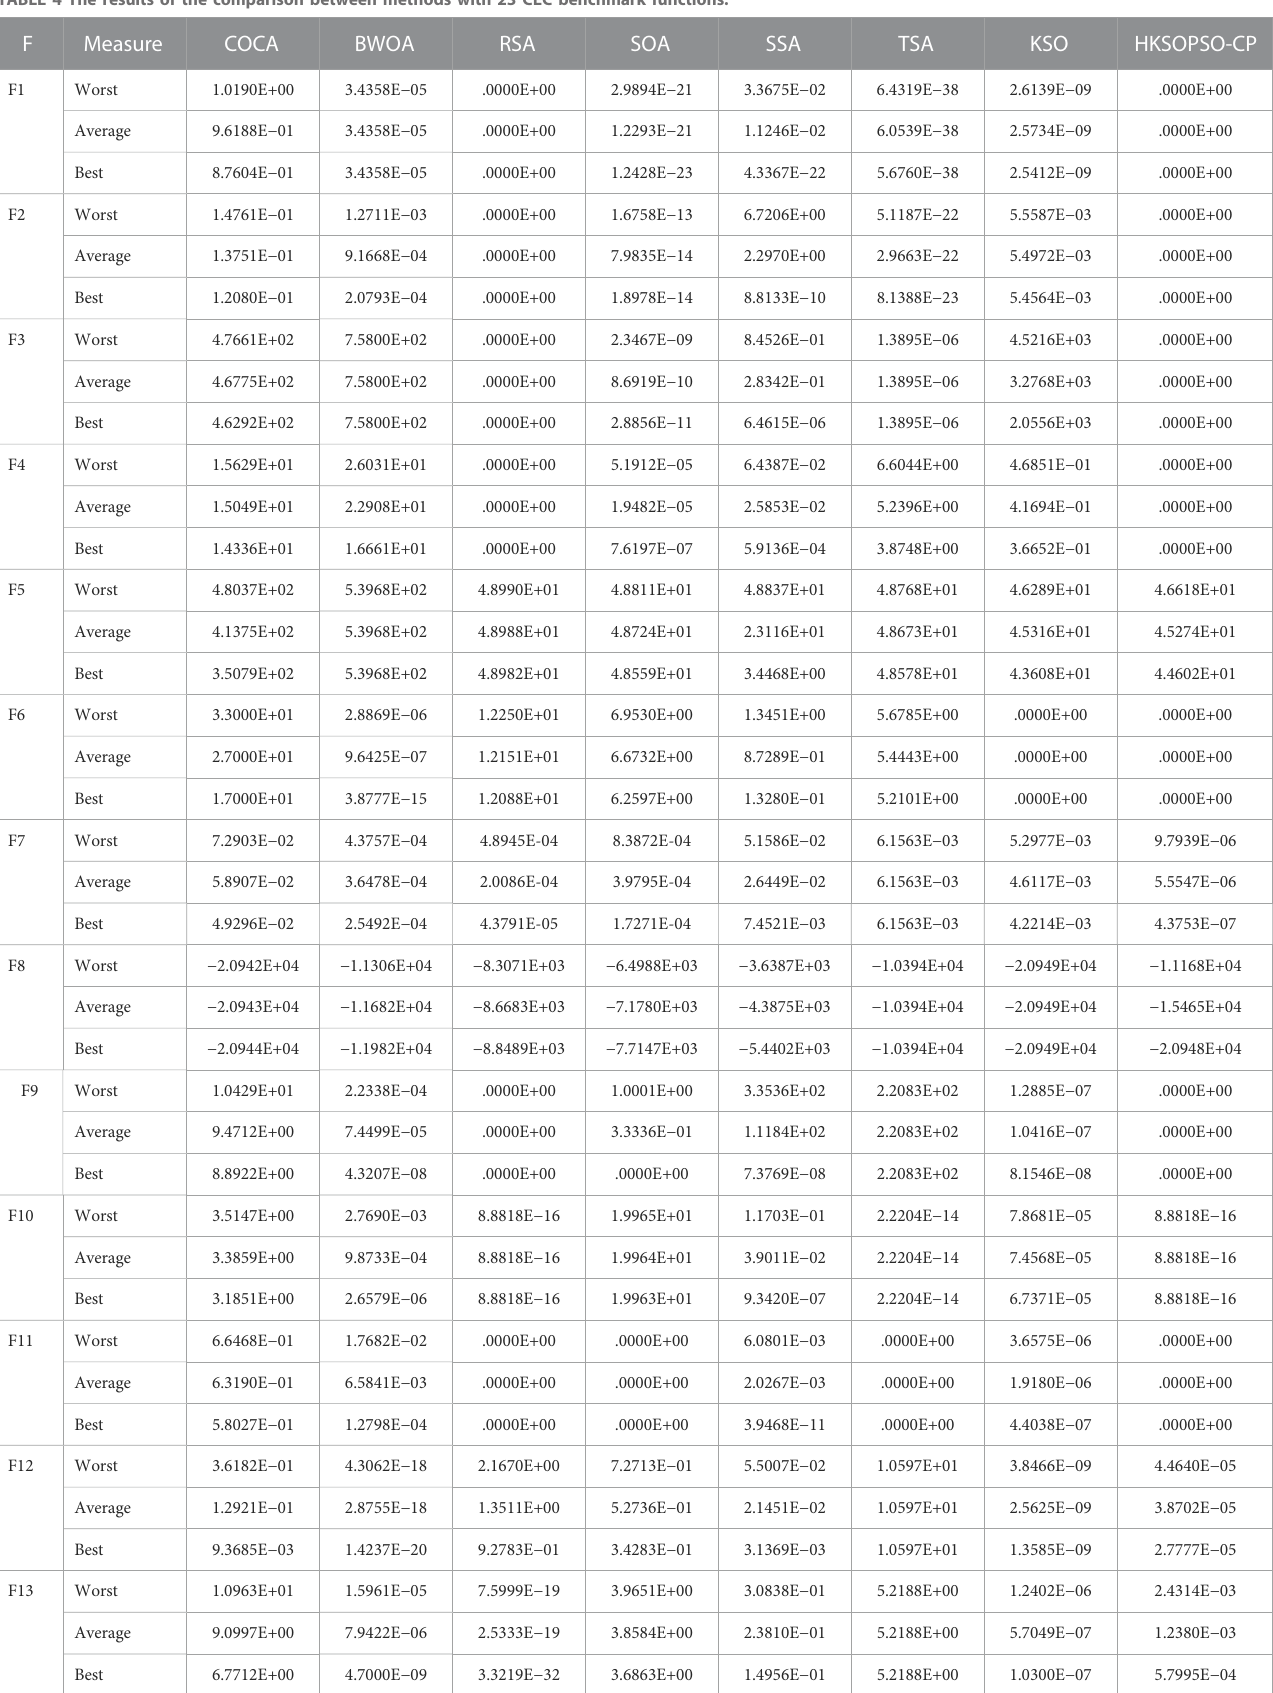
TABLE 4 The results of the comparison between methods with 23 CEC benchmark functions.